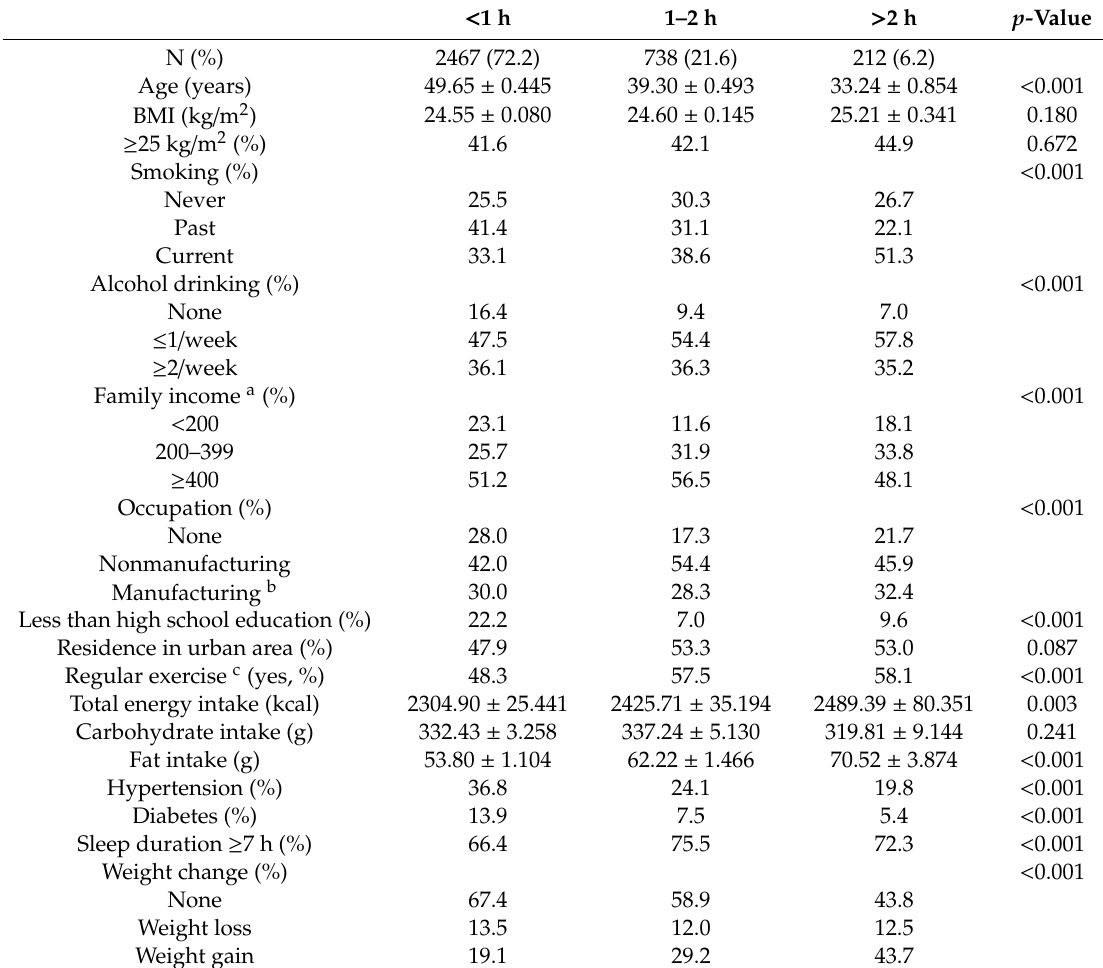
Table 3. Characteristics of the study population according to social jetlag in